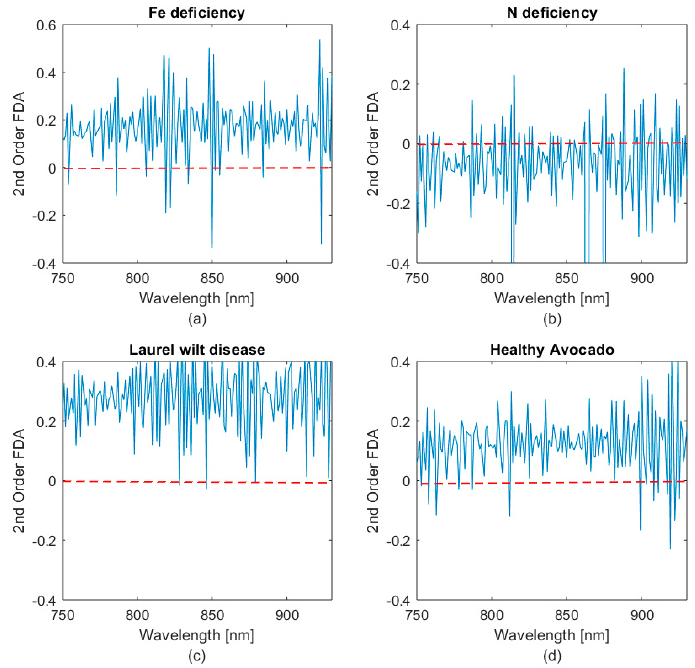
Figure 4. Finite Di ff erence Approximations for each group of avocados in [750, 950] nm: ( a ) Fe-Deficient Figure 4. Finite Difference Approximations for each group of avocados in [750, 950] nm: ( a ) Fe ‐ FDA; ( b ) N-deficient FDA; ( c ) Lw disease FDA; and ( d ) Healthy plants FDA; normalized, Deficient FDA; ( b ) N ‐ deficient FDA; ( c ) Lw disease FDA; and ( d ) Healthy plants FDA; normalized,